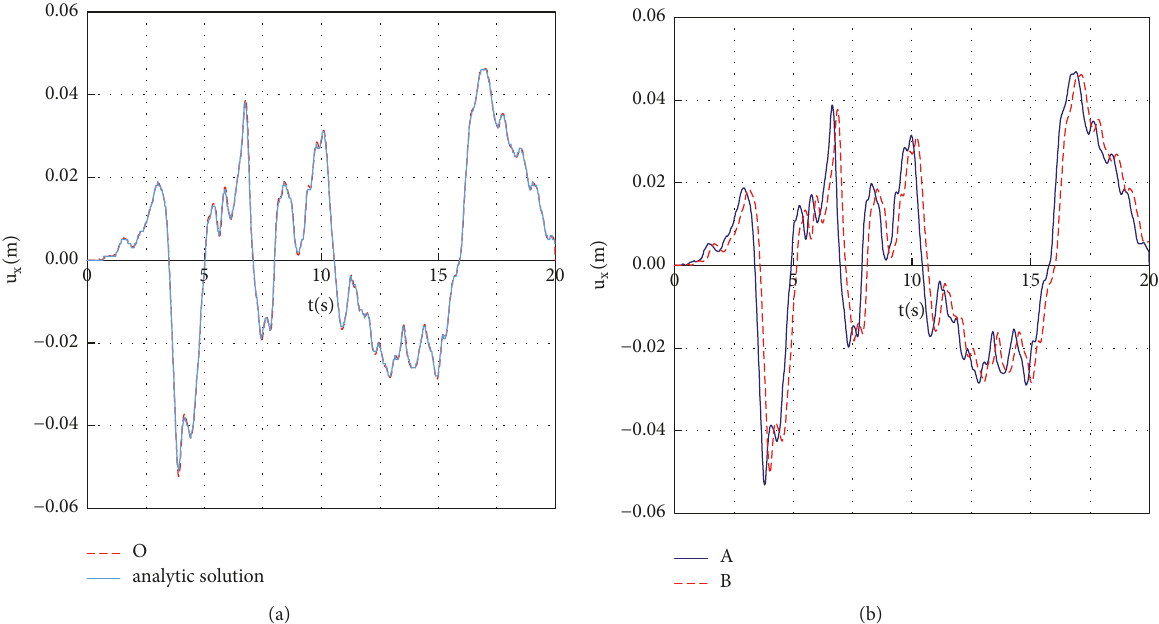
Figure 12: Horizontal displacement histories of typical points: (a) point O and (b) points A and B.